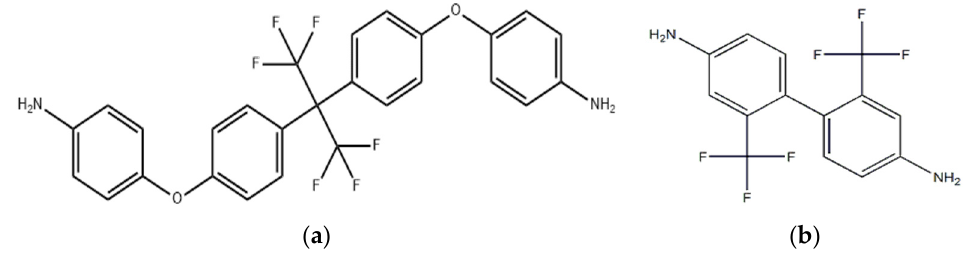
Figure 1. ( a ) Molecular structure of HFBAPP; ( b ) Molecular structure of TFMB.